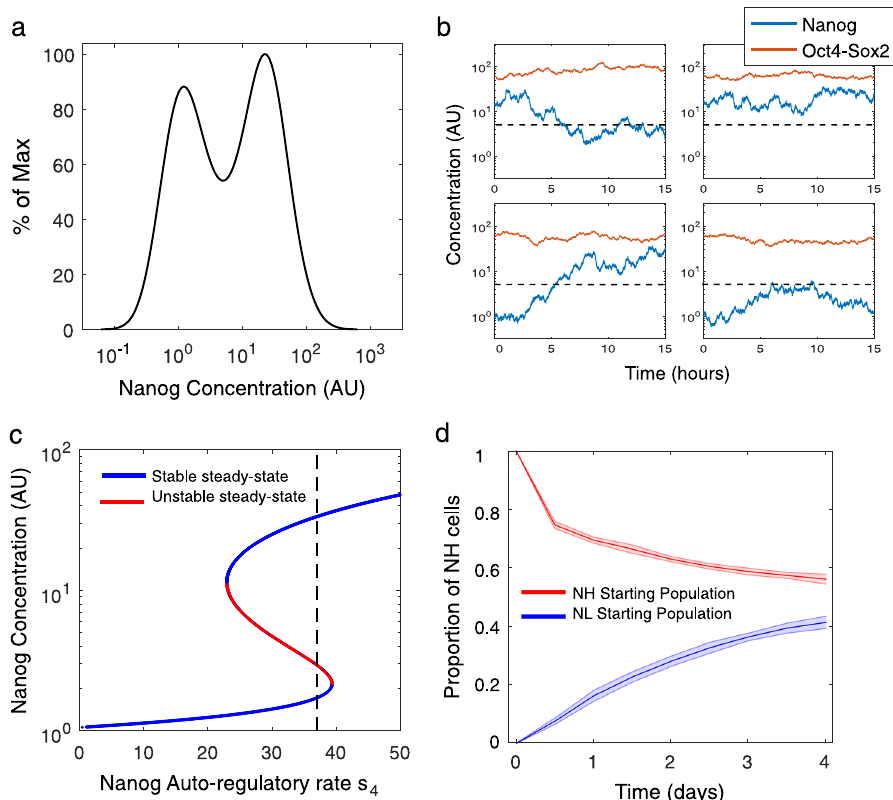
Fig. 2 System dynamics and stability in serum/LIF (PD = Chiron = 0 AU) a Steady-state distribution of Nanog simulated in 1000 cells showing that approximately 50% of the cells are in Nanog High (NH) and 50% Nanog Low (NL) states. b Four representative time-course simulations of Nanog ( blue line ) and Oct4-Sox2 ( red line ) in single cells over 15 h. Oct4-Sox2 dimer concentration remains fairly constant compared to Nanog. The horizontal black dotted line represents the threshold between NH and NL. c Continuation of Nanog steady-state for the deterministic system (no noise). Blue lines are stable steady-states, while the red line is unstable. The maximal transcription rate, s 4 ( dotted black line ), intersects both NH and NL steady-states, indicating bistability. d Sorting simulation: the dynamics of NH or NL cells (1000 for each state) are simulated over 4 days, and the proportion of cells in the NH state is recorded every 12 h ( n = 10, shaded areas indicate standard deviation). The simulations show the cells tending towards the steady-state distribution of approximately 50% NH and 50%